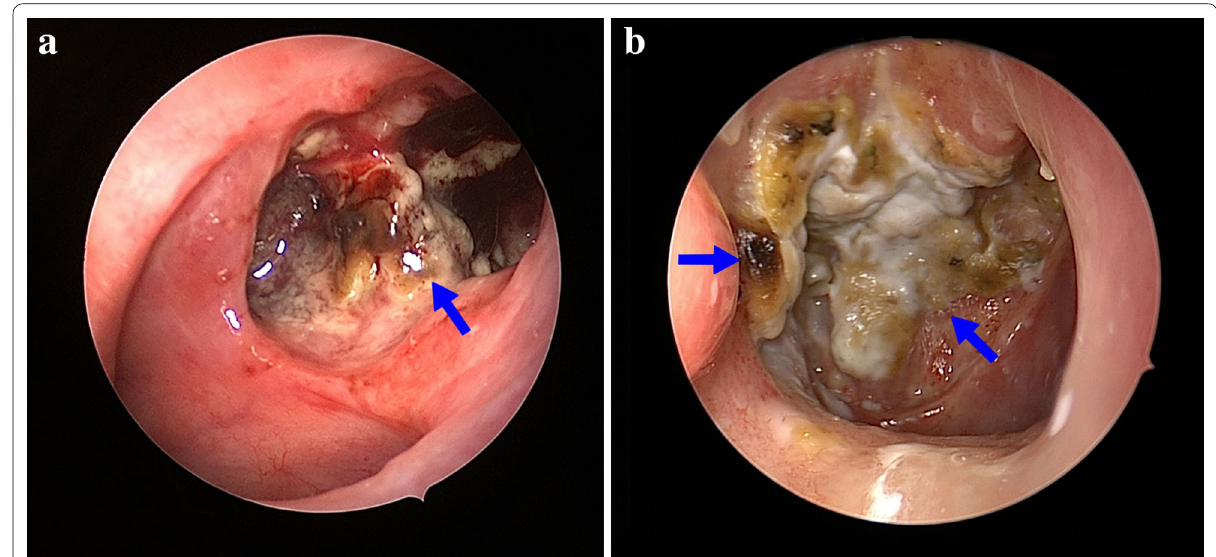
Fig. 3 Endoscopic examination of nasopharyngeal necrosis. Nasopharyngeal necrosis is shown under endoscopic examination ( arrows ). a The necrosis is located in the roof, posterior, and left wall with obvious mucosa ulcer. Sequestra and necrotic bones can also be seen in the nasopharyn‑ geal cavity. b The nasopharyngeal cavity is covered with yellow to black purulent secretion with necrosis located in the roof, posterior, and right lateral wall of the